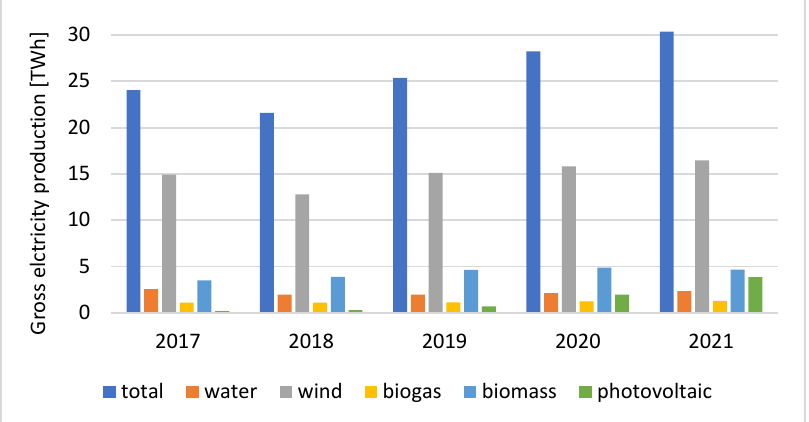
Figure 2. Gross electricity production from renewable energy sources in Poland 2017 – 2021 (GWh). Source: own elaboration on the basis of data from https://www.are.waw.pl/, accessed on 11 November 2022. Table 1. Number of electricity prosumers in Poland in 2017 – 2021. Source: own elaboration on the basis of data from https://www.are.waw.pl/, accessed on 11 November 2022.